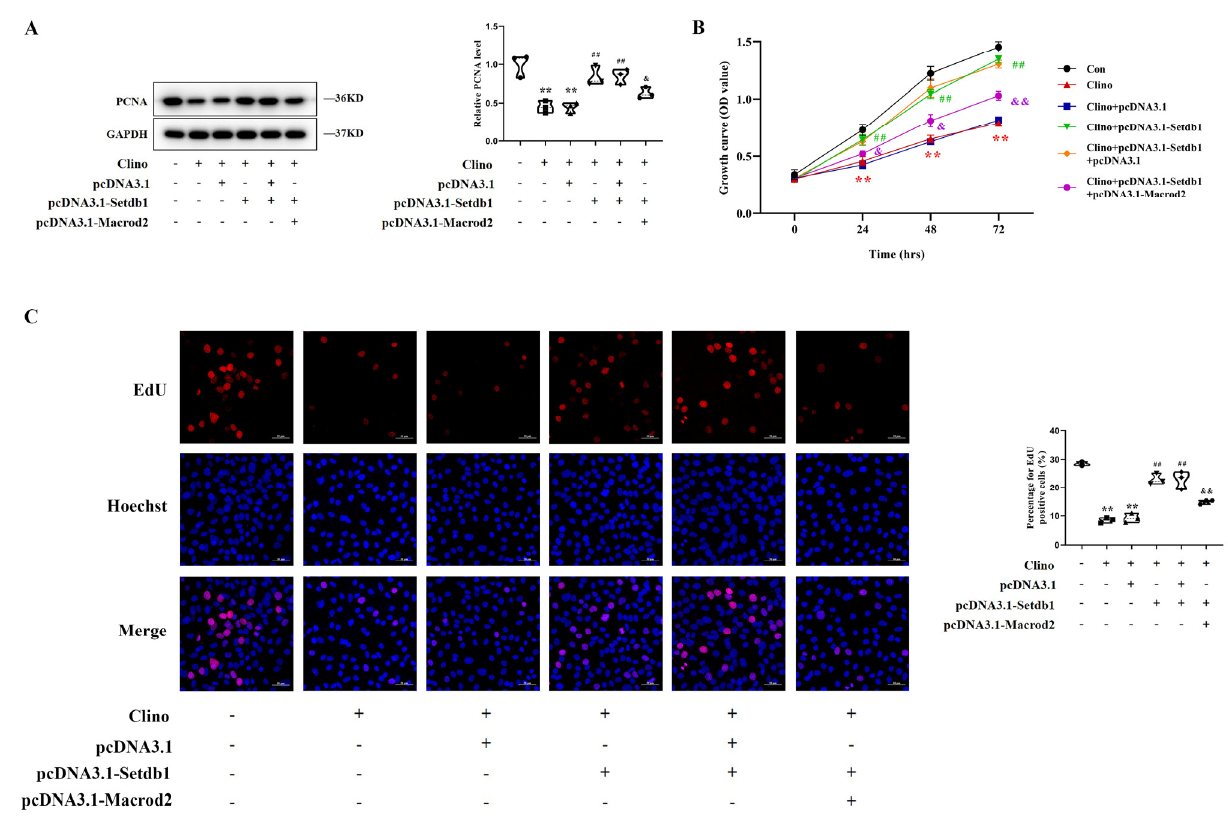
Figure 6. Setdb1 blocks the inhibition of osteoblast proliferation under mechanical unloading by targeting Macrod2. ( A ) PCNA protein expression measured by Western blotting after MC3T3-E1 cells were transfected with pcDNA3.1-Setdb1 alone or pcDNA3.1-Setdb1 plus pcDNA3.1-Macrod2 and subjected to clinorotation-unloading for 48 h ( n = 3). One-way ANOVA followed by LSD’s multiple comparisons test. ( B ) Cell proliferation assessed by a CCK-8 assay in MC3T3-E1 cells in the indicated groups ( n = 3). Repeated measures ANOVA. ( C ) The EdU labeling assays by confocal microscope from each group ( n = 3). Scale bar, 50 µ m. One-way ANOVA followed by LSD’s multiple comparisons test. ** p < 0.01 vs. the control cells. ## p < 0.01 vs. the cells transfected with pcDNA3.1 before unloading. & p < 0.05 vs. the cells co-transfected with pcDNA3.1 and pcDNA3.1-Setdb1 before unloading. && p < 0.01 vs. the cells co-transfected with pcDNA3.1 and pcDNA3.1-Setdb1 before unloading.